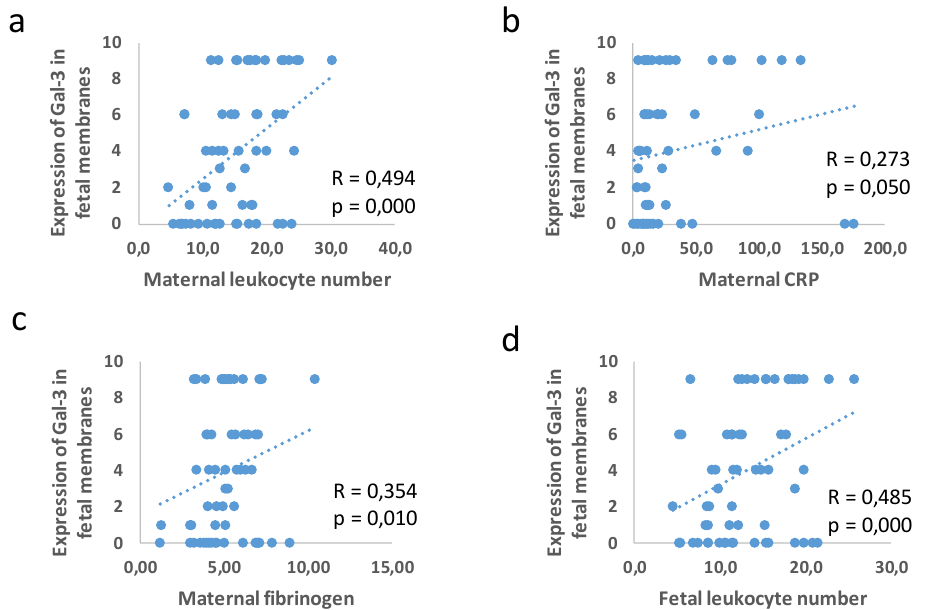
Figure 7. Correlation in expression of Gal-3 in fetal membranes and leukocyte number in maternal blood ( a ), maternal CRP ( b ), maternal fibrinogen ( c ), and leukocyte number in fetal blood ( d ). The Gal-3 expression in the decidua was associated with the maternal leukocyte number (R = 0.403; p = 0.007) and fibrinogen (R = 0.324; p = 0.032) and the fetal blood leukocyte number (R = 0.387; p = 0.009) (Figure 8).